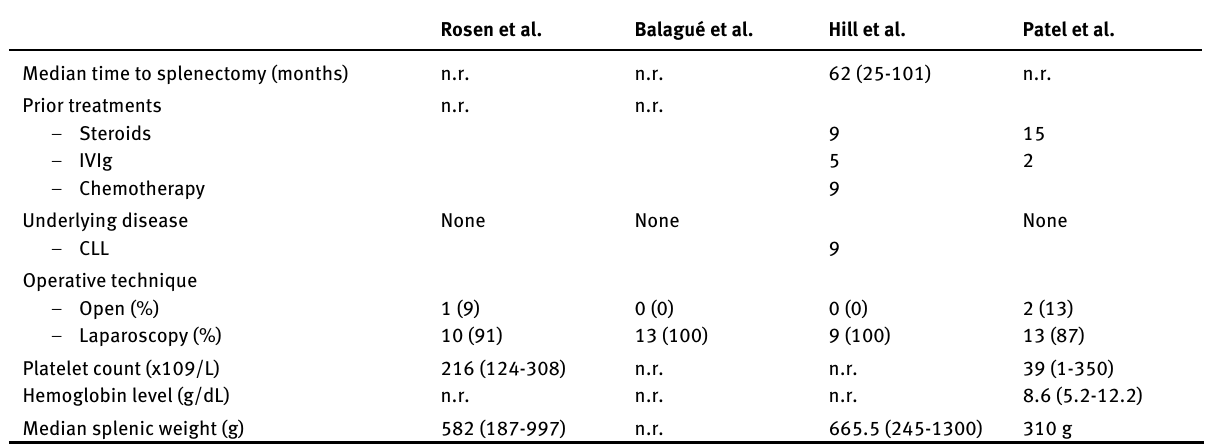
Table 4: Preoperative